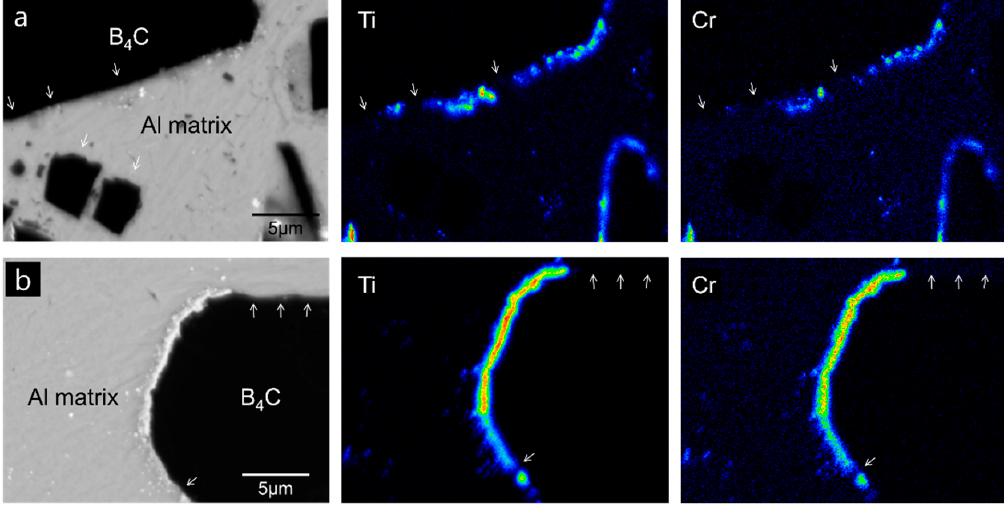
Figure 4. EPMA analysis of ( a ) B 4 C/Al6061 stir-cast AMCs and ( b ) hot-rolled AMCs at 30 vol.% B 4 C.